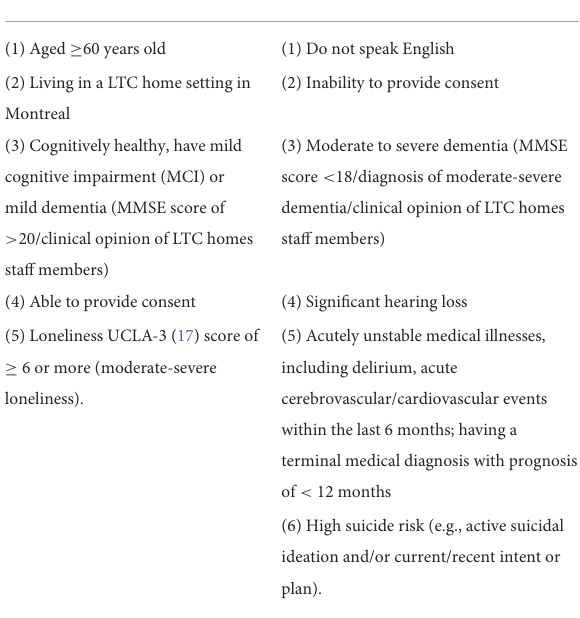
TABLE 1 Eligibility